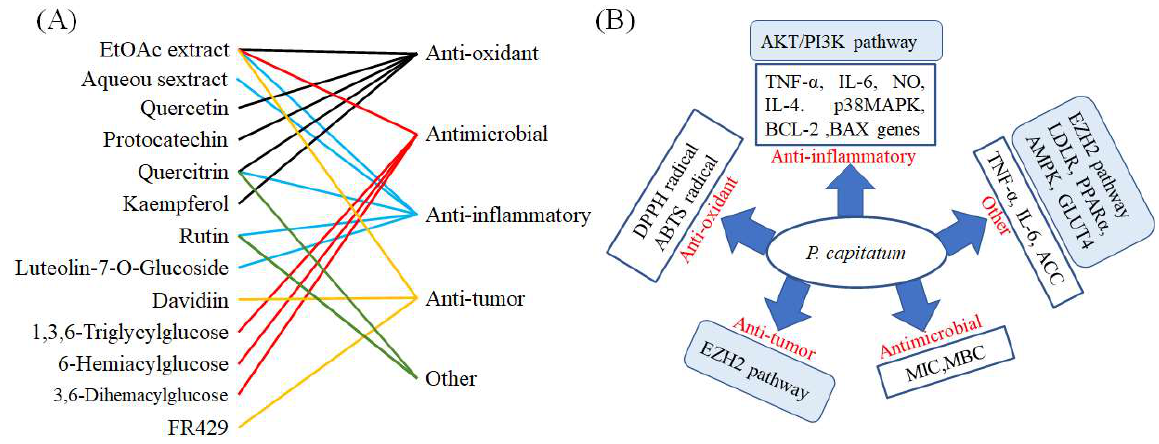
Figure 3. The bioactivities ( A ) and proposed mechanisms ( B ) of P. capitatum compounds.